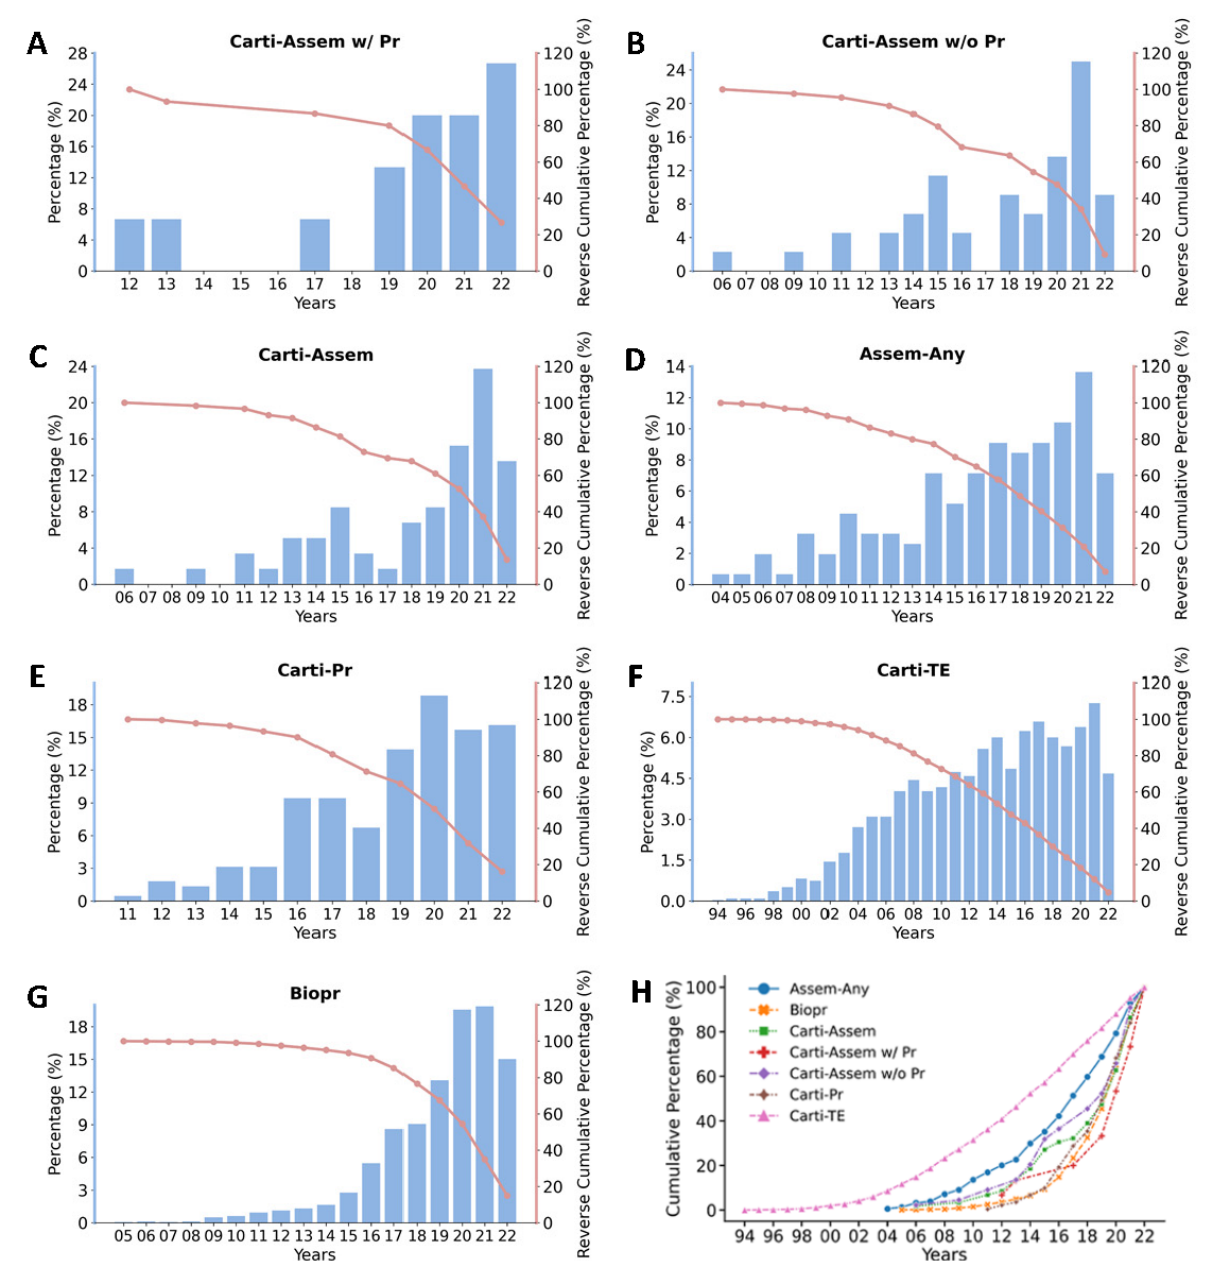
Figure 4. Analysis of the year trends of publication of seven categories in cartilage bioassembly, bioprinting, and tissue engineering. ( A – G ) Bar plots demonstrate the percentage of articles published each year. Line plots demonstrate the reverse cumulative percentage of articles published in each category. ( H ) Line plots demonstrate the cumulative percentage of articles in each category published in the last 28 years. Abbreviations: “Carti-Assem w/Pr”: micro-cartilage bioassembly with bioprinting; “Carti-Assem w/o Pr”: micro-cartilage bioassembly without bioprinting; “Carti-Assem”: Micro-cartilage bioassembly using any technologies; “Assem-Any”: bioassembly of any tissues; “Carti-Pr”: cartilage bioprinting; “Carti-TE”: cartilage tissue engineering; “Biopr”: bioprinting.